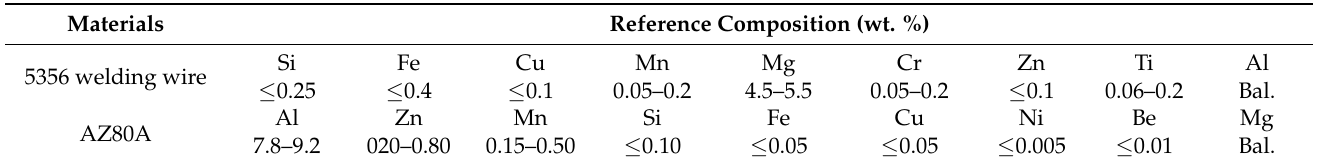
Table 1. Chemical composition of the base metal and filler metal. Reference Composition (wt.